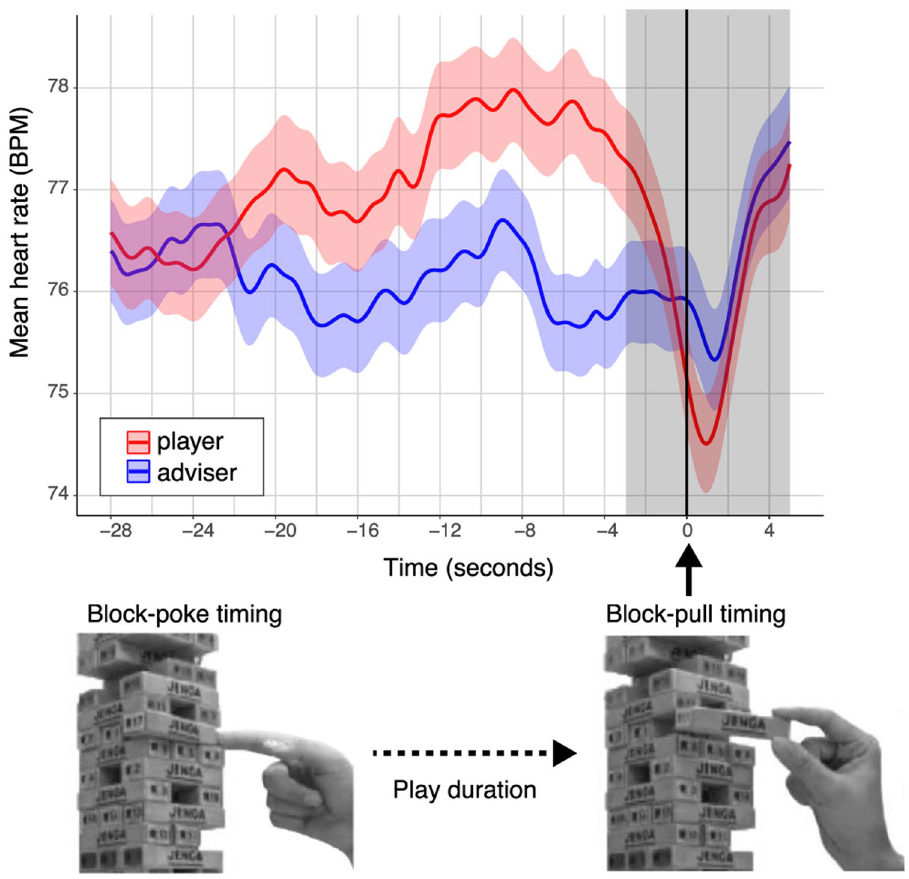
represents the timeline, with time zero seconds marking the start of block-pull timing. The grey shaded area demarcates the time during which heart rates temporarily decreased and then increased (i.e., from 3 s before